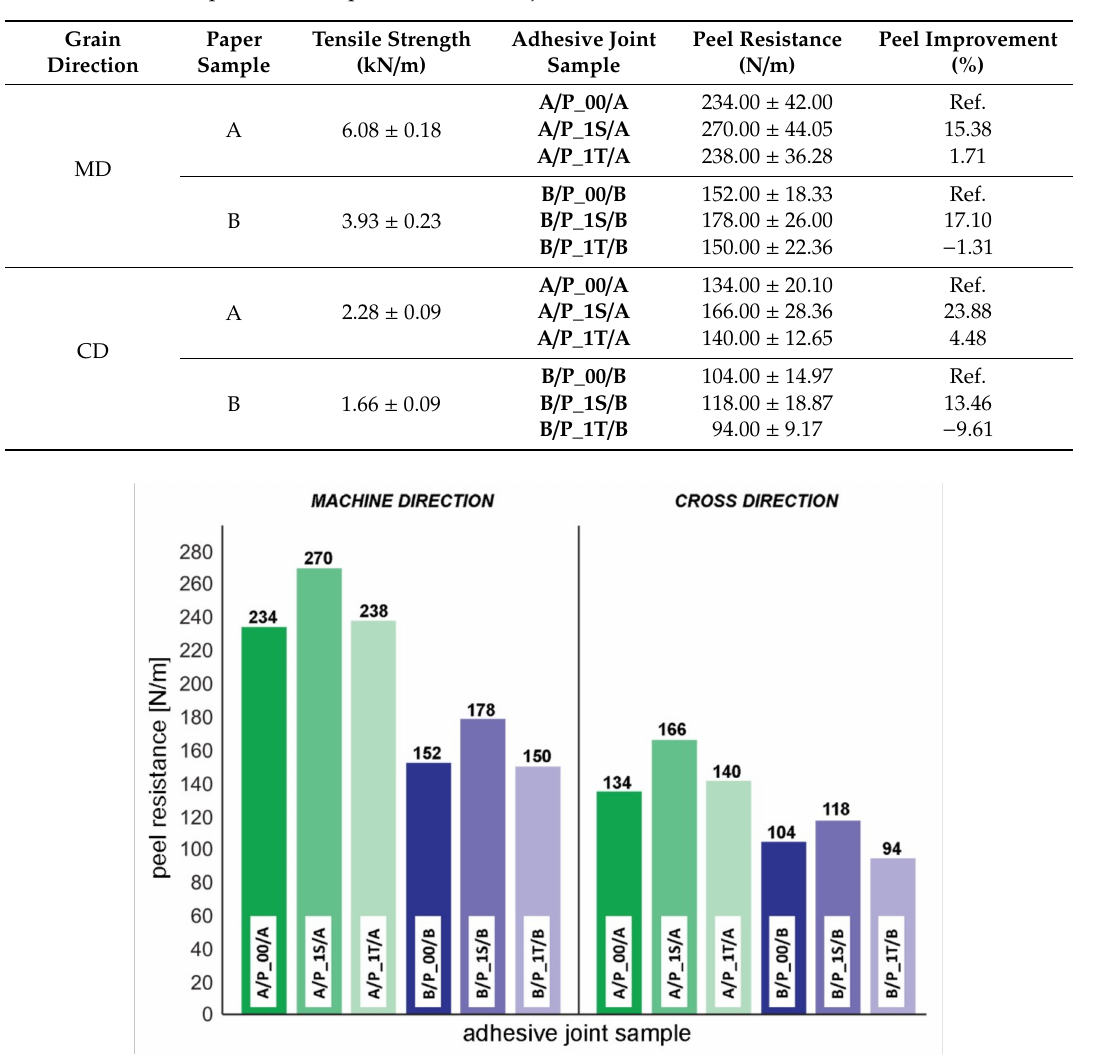
Figure 8. Comparison of the obtained results for peel resistance of adhesive joint samples—machine grain direction (MD) and cross grain direction